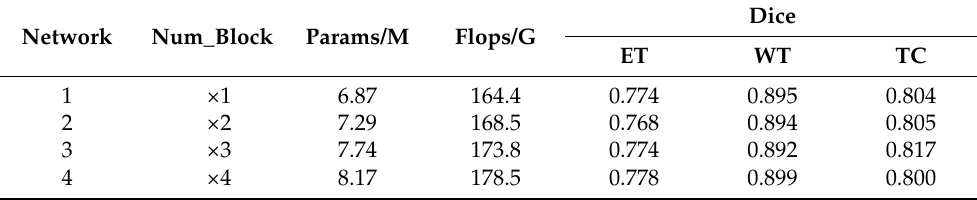
Figure 8. The Dice coefficients of the baseline with different num_block on the BraTS 2020 valida- tion set. Table 6. The evaluation metrics of baseline using different num_block.